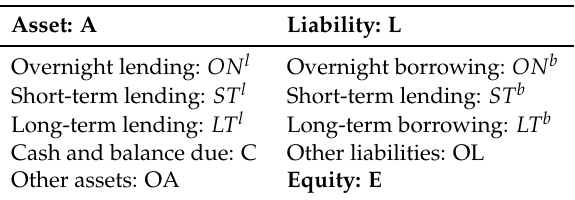
Table 2. Description of the bank balance